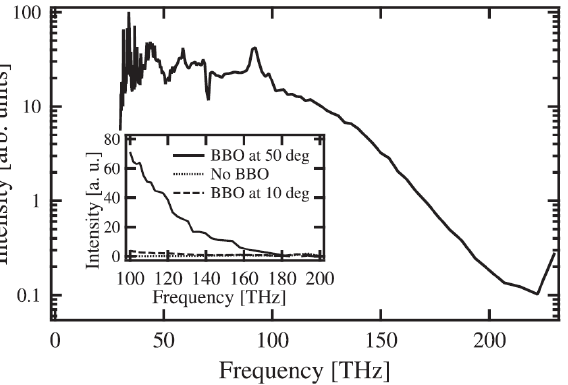
Figure 2. A spectrum of the ultrabroadband pulse from far infrared to 200 THz through a plasma [28].